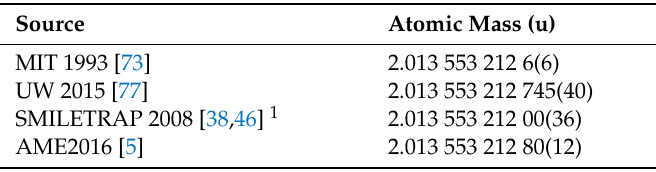
Table 2. Atomic mass values for the